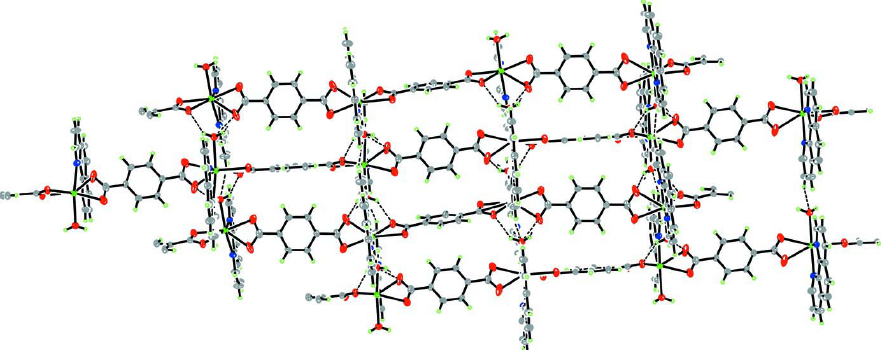
Figure 3 The layered structure of compound (I), constructed by